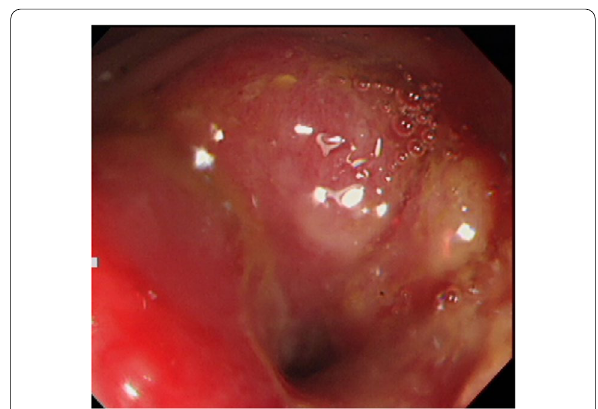
Fig. 1 Colonoscopy revealed a sigmoid colon cancer with all circumference-related stenosis